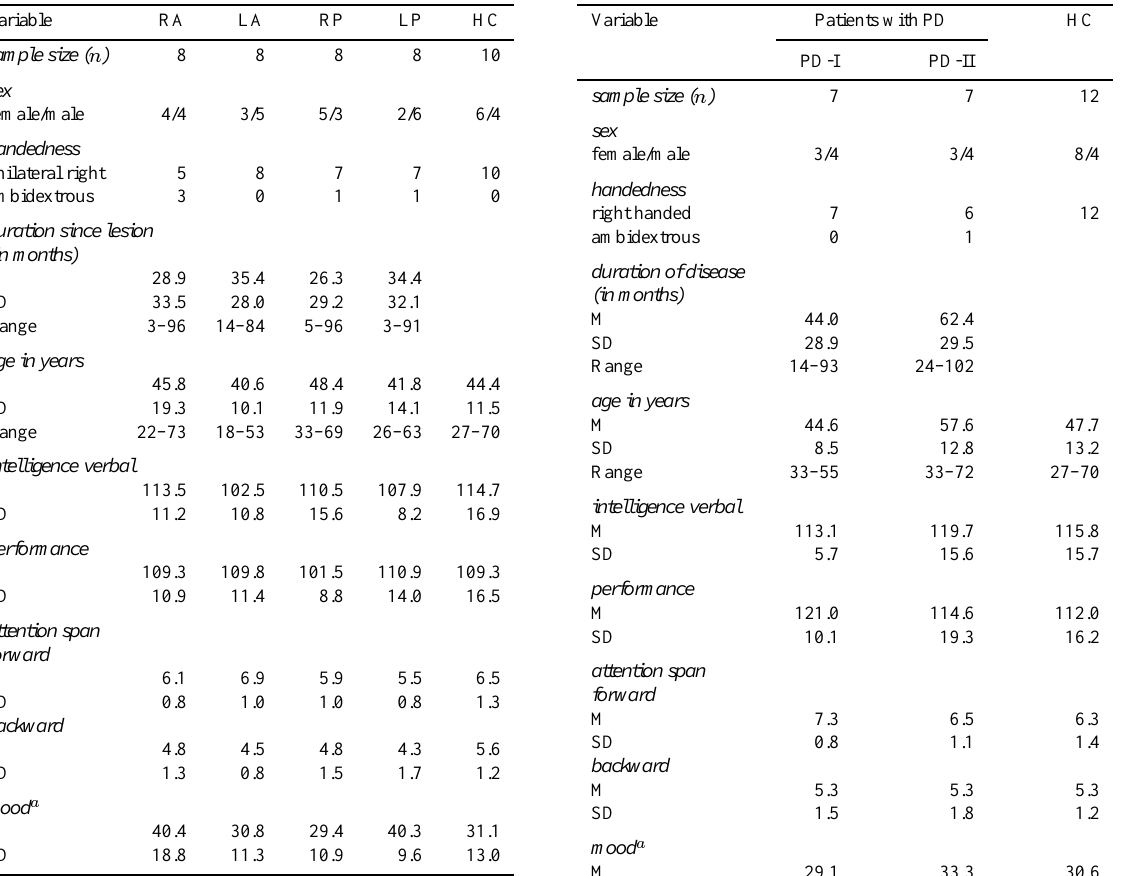
Table 2 Demographic and neuropsychological data (patients with cortical